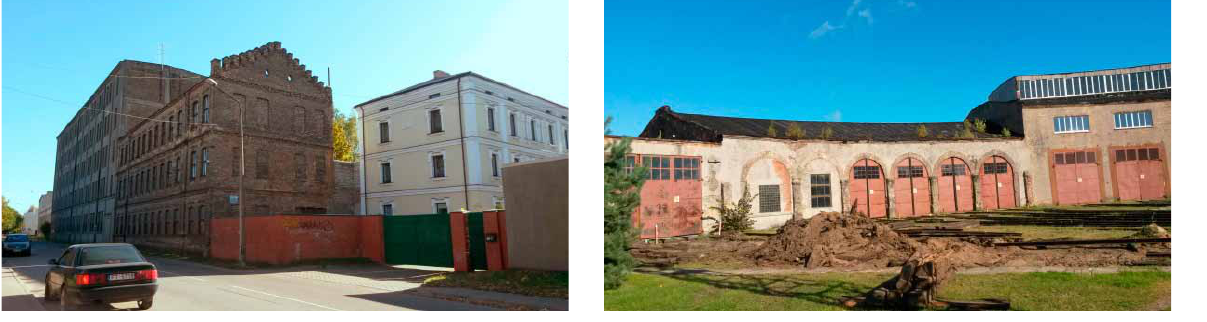
fig. 5. Kramer key factory (80s of the 19 th century) fig. 6. repair factory of the steam locomotive (90s of the 19 th